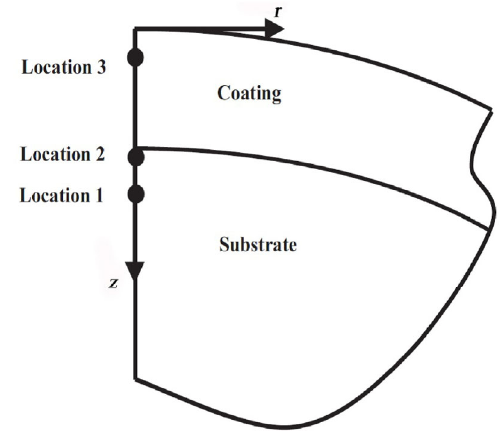
Fig. 4 Typical locations of yield inception in a coated sphere compressed by a rigid flat [25].